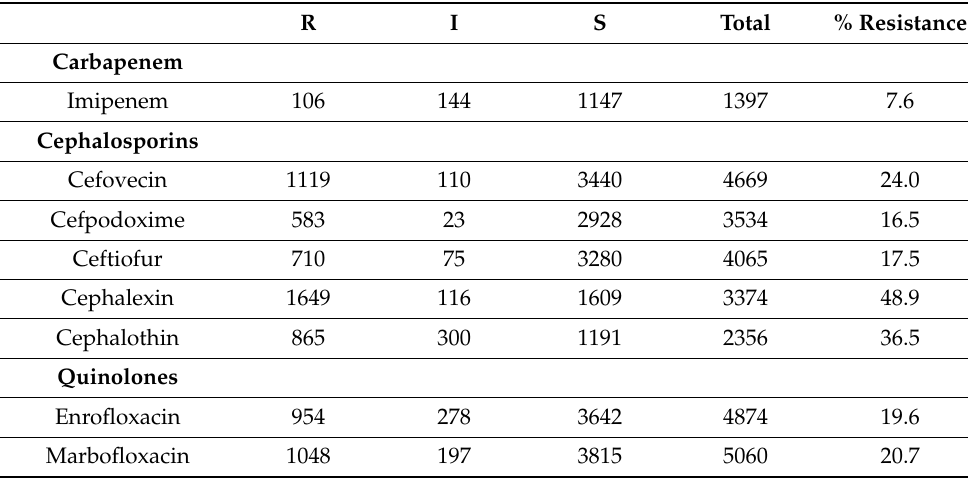
Table 2. The pattern of antimicrobial sensibility in the 5306 isolates between 2017 and 2021 (R— resistant, I—I-intermediate, S—sensible) to aminoglycosides, glycosides, macrolides, and nitrofu- rans.